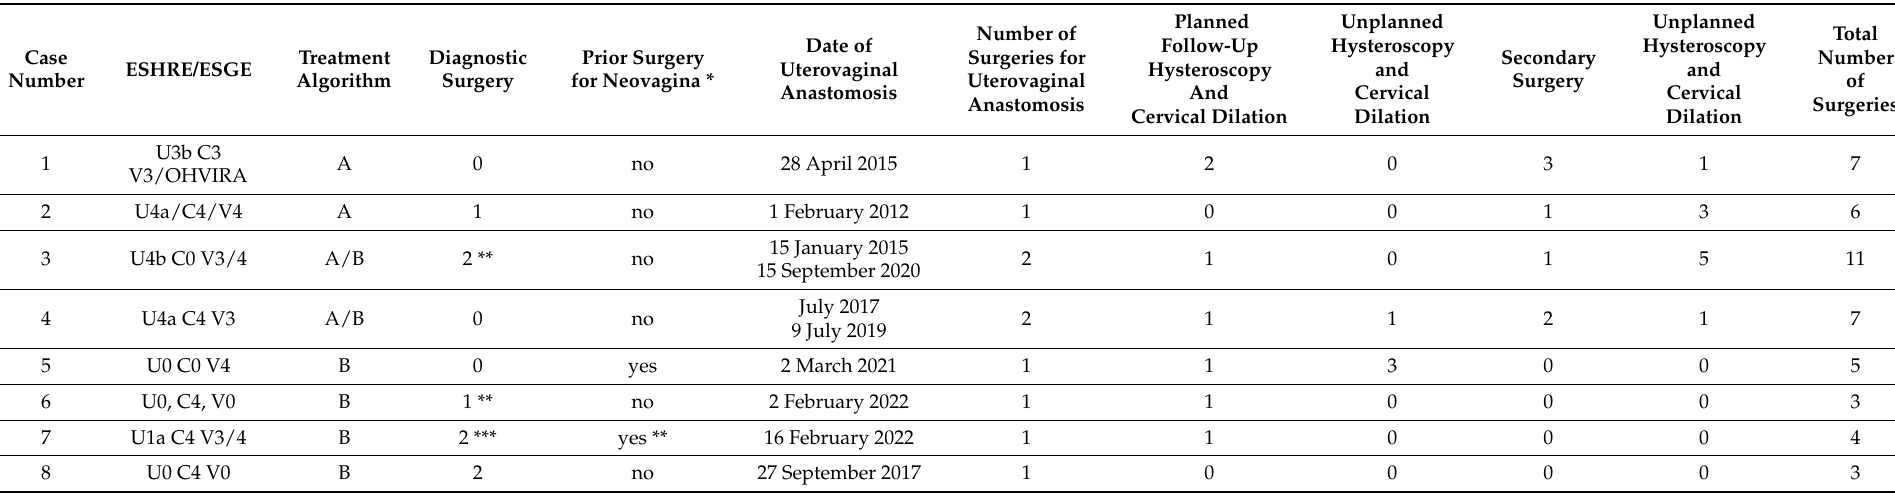
Table 2. Surgical outcome